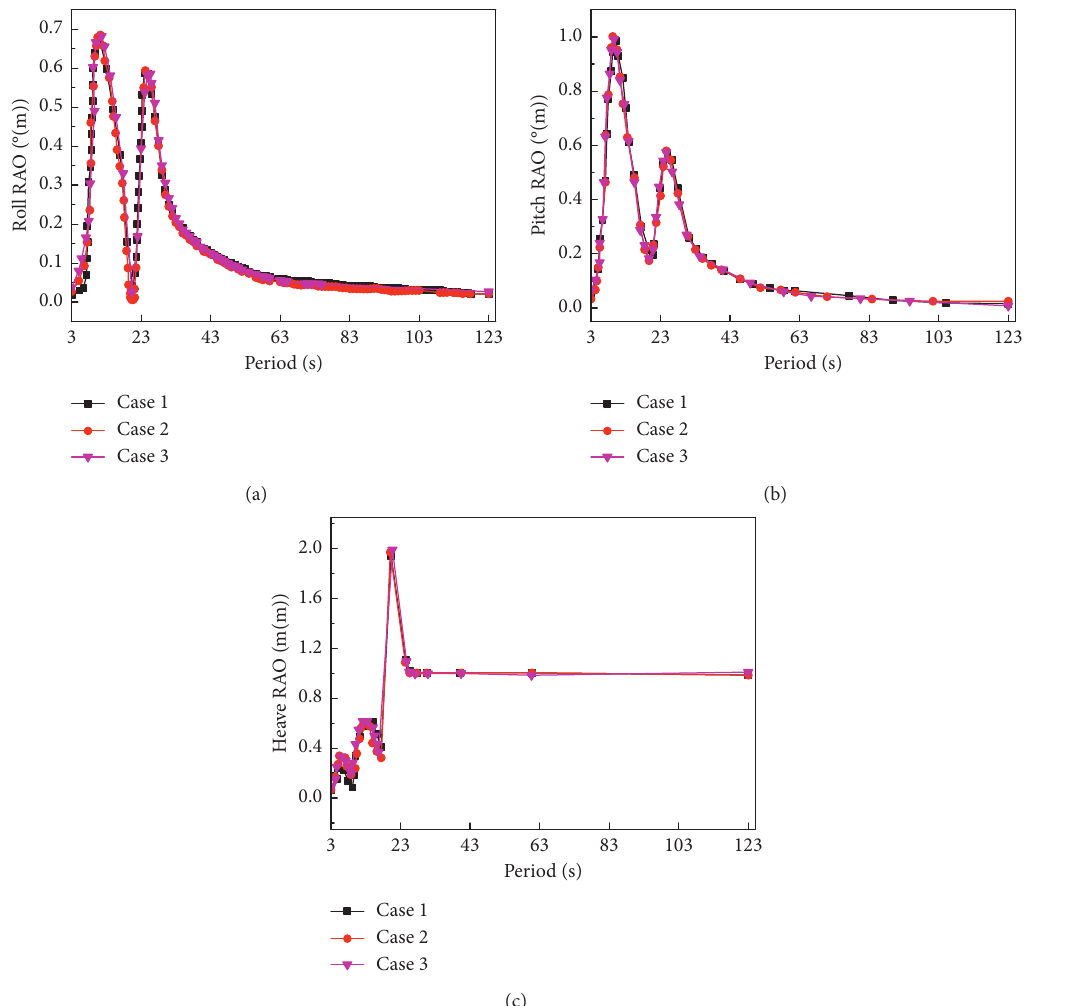
Figure 15: The motion response of the platform with different pontoon end shapes. (a) Roll, (b) pitch, and (c)